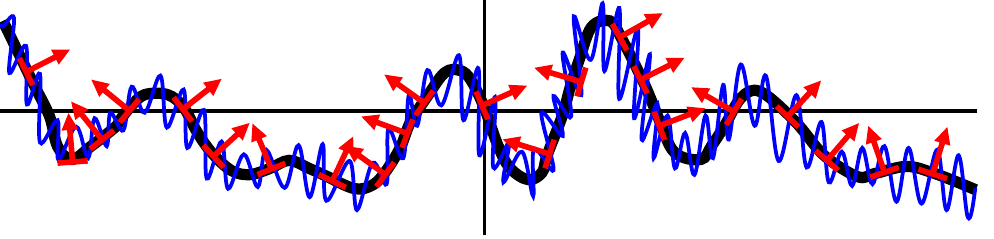
Figure 5. Schematic of the sea surface using a two-scale model. The black curve expresses the long wave, while the blue curves show the short waves propagating on the long wave. The red lines represent the wave facets and the red arrows give denote normal direction, which illustrates the changes of local incidence angles.